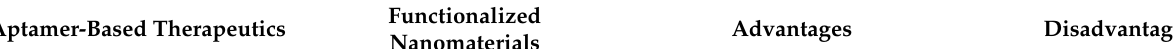
Table 1. Advantages and disadvantages of aptamer-based therapeutics developed with different